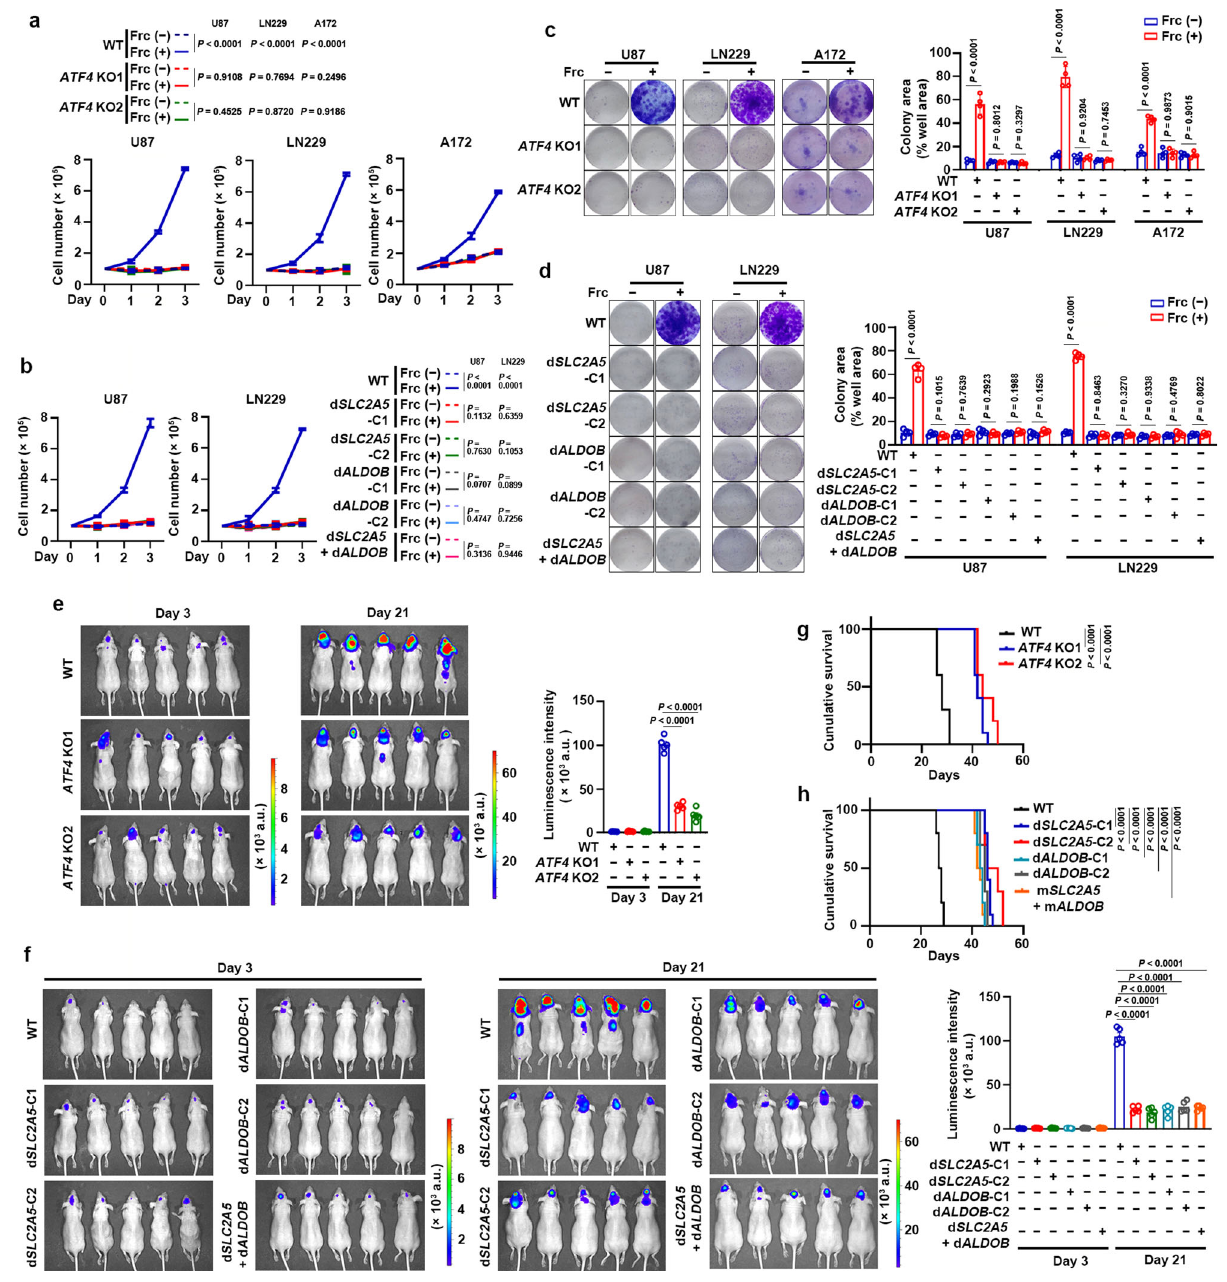
Fig. 4 | ATF4-dependent fructolysis rescues glucose-deprivation impaired proliferation and colony formation of GBM cells and is required to maintain GBMgrowth.a , b IndicatedGBMcellswithoutorwith ATF4 KO( a )orATF4binding de fi ciency in the promoters of SLC2A5 or ALDOB ( b ) were cultured under glucose- deprived condition supplemented without or with fructose for 3 days. The cells werethencollectedandcounted. c , d IndicatedGBMcellswithoutorwith ATF4 KO ( c ) or ATF4 binding de fi ciency in the promoters of SLC2A5 or ALDOB ( d ) were culturedunderglucose-deprivedconditionsupplementedwithoutorwithfructose for 14 days. The cells were then fi xed by 4% paraformaldehyde and stained with crystal violet. Colony formation areas in each dish were analyzed by ImageJ soft- ware. e , f Luciferase-expressing U87 cells without or with ATF4 KO ( e ) or ATF4 binding de fi ciency in the promoters of SLC2A5 or ALDOB ( f ) were intracranially injected into athymic nude mice ( n =5). Luminescence intensity derived from